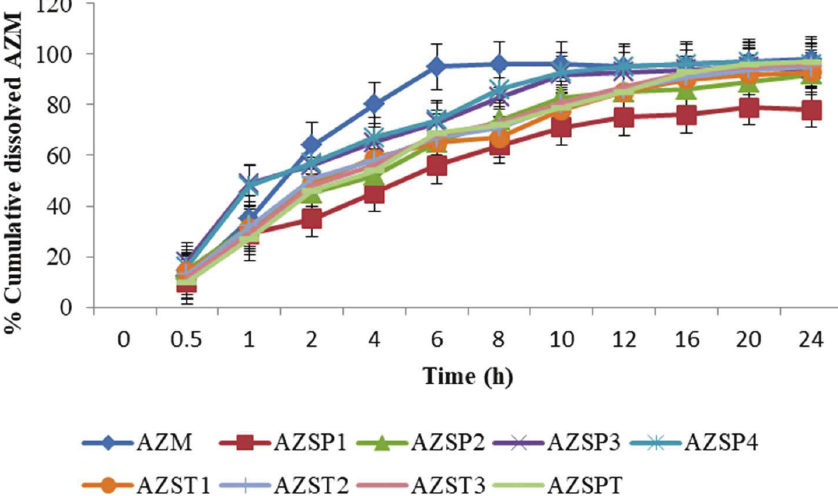
Fig. 6. Dissolution rate of azilsartan microparticles prepared from stearic acid (values represent mean±SD, n